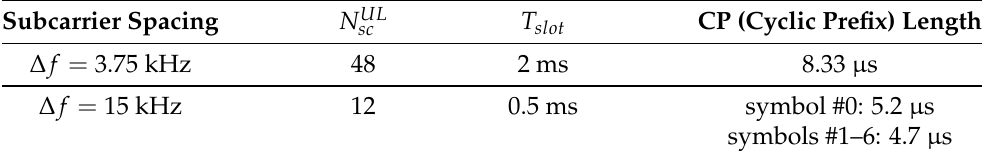
Table 3. NB-IoT parameters [2].